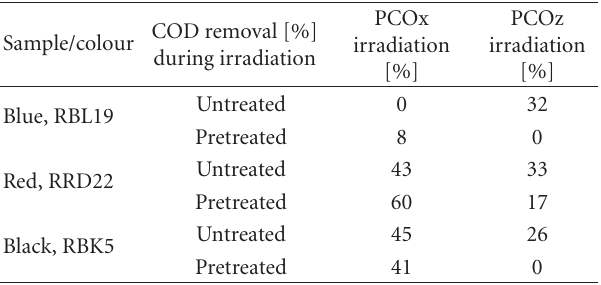
Table 3: COD removal of samples during irradiation